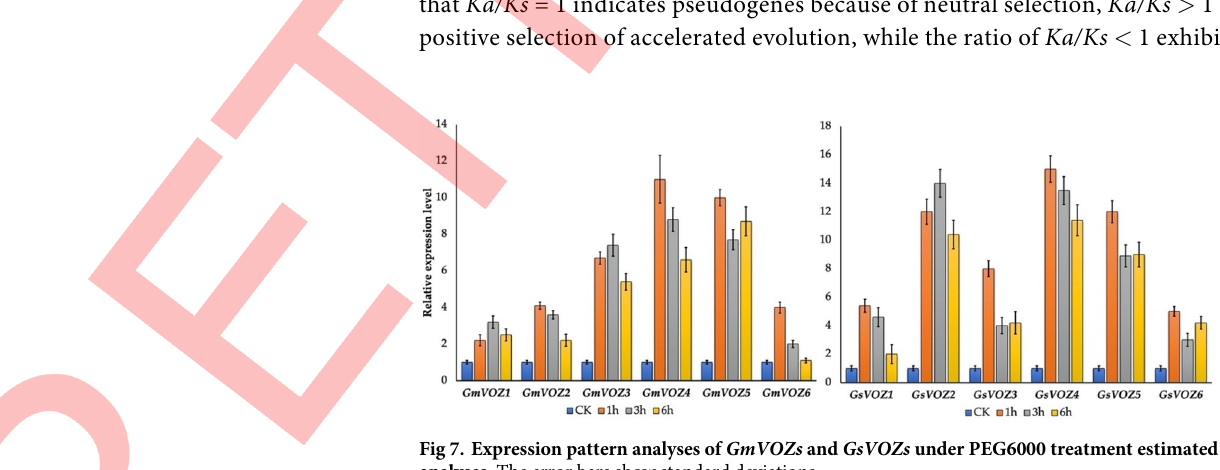
Fig 7. Expression pattern analyses of GmVOZs and GsVOZs under PEG6000 treatment estimated by qRT-PCR analyses. The error bars show standard deviations.